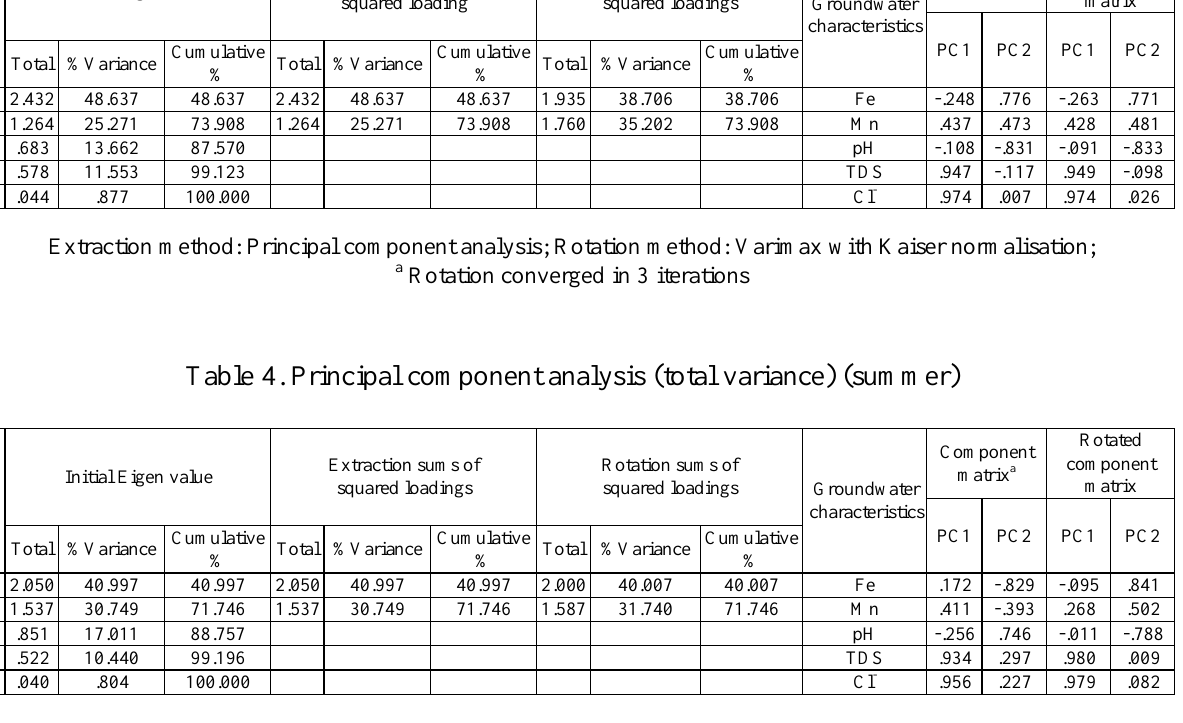
Rotation sums of squared loadings